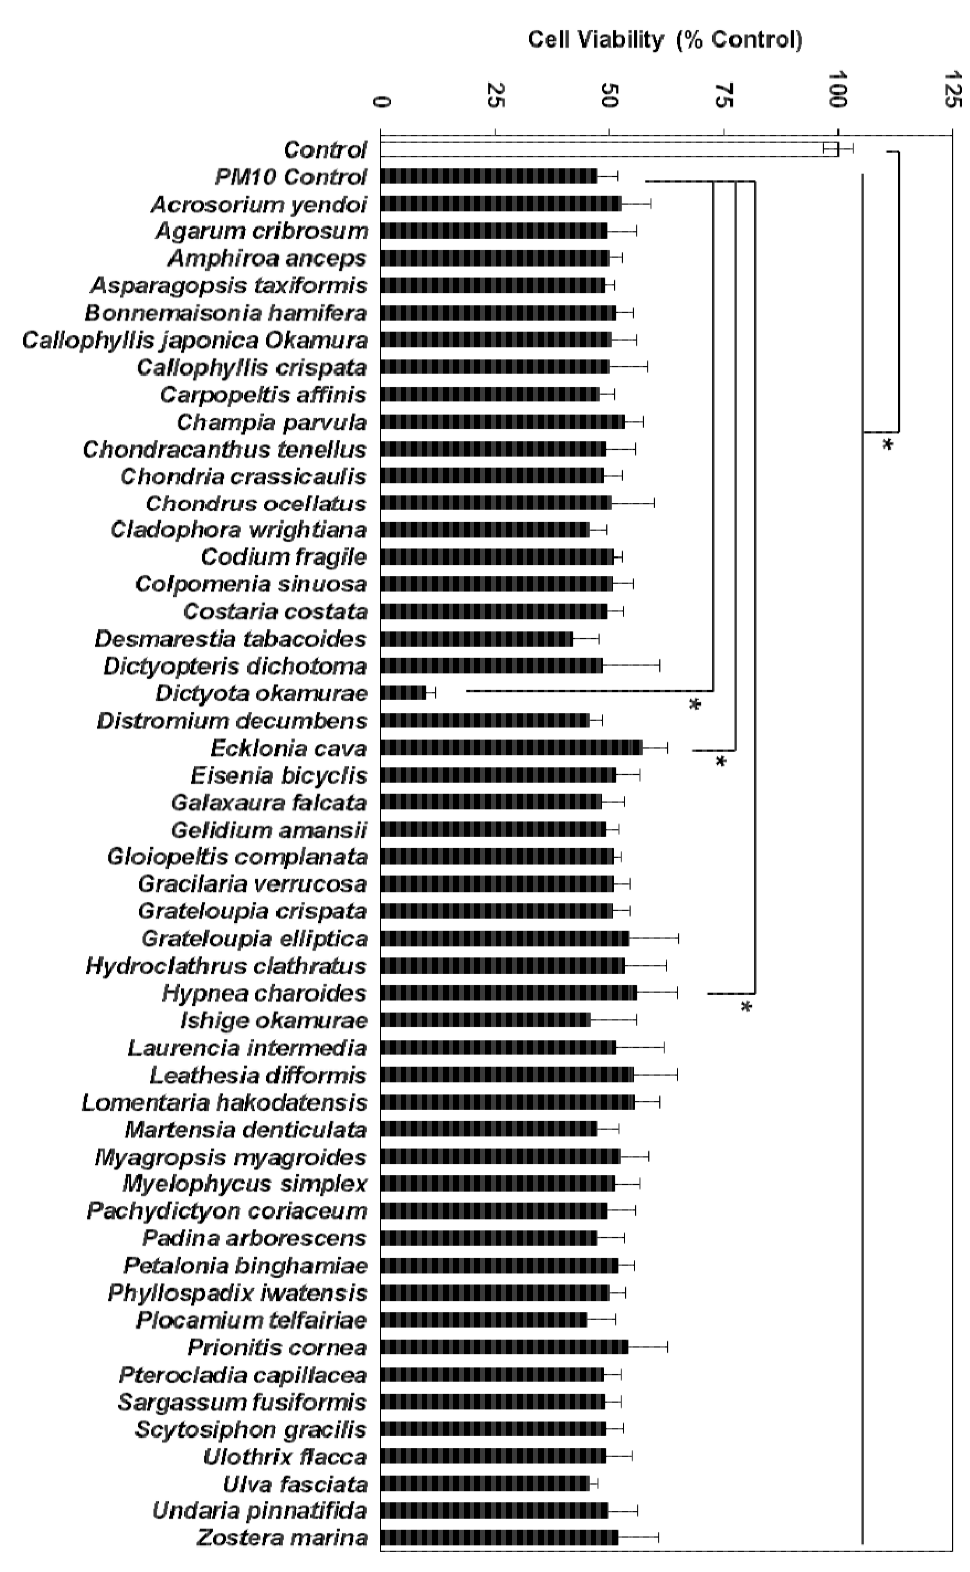
Figure 2. Effects of marine alga extracts on the viability of HaCaT keratinocytes exposed to PM10. Cells were treated with 200 μ g mL − 1 PM10 for 48 h in the presence or absence of each extract at 50 μ g mL − 1 . Data are presented as a mean ± SD ( n = 4). All treatments (50 extracts) were compared to the PM10 control using one-way ANOVA followed by Dunnett’s test. * p < 0.05.